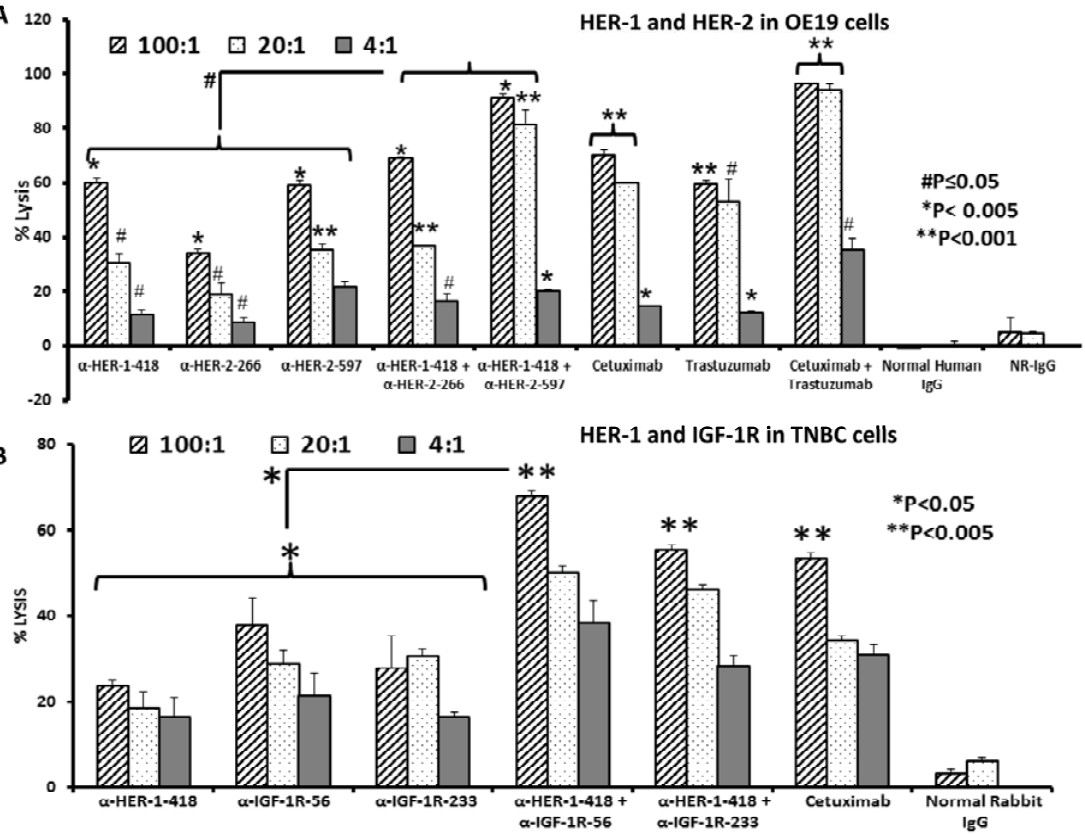
Figure 2. Co-targeting HER-2 and HER-1 or IGF-1R and HER-1 causes greater induction of ADCC in EC and TNBC. OE19 or MDA-MB-231 cells were used as target cells and were seeded and incubated in the presence of human PBMCs at different effector: Target cell ratios (100:1, 20:1, 4:1). Cells were then treated for one hour with peptide vaccine antibodies prior to cell lysis. The aCella-tox kit (Cell Technology, Inc.; Fremont, CA, USA) was used to measure the relative amount of ADCC; cell lysis was measured according to the manufacturer’s instructions. Results represent an average of two different experiments performed in triplicate and display the % lysis of treatment groups when compared to 100% target cell lysis. Normal human and rabbit IgG (Pierce, Rockford, IL, USA) were used as a negative control; cetuximab and trastuzumab were positive controls . In EC cells, at a 100:1 ratio ( A ), single treatment with the anti-HER-2 and anti-HER-1 peptide vaccine antibodies showed significant induction of ADCC (* p < 0.005), but combination treatment using the anti-HER-1-418 and anti-HER-2-597 or anti-HER-1-418 and anti-HER-2-266 peptide vaccine antibodies caused greater induction of ADCC (# p < 0.05) than single treatment alone. In TNBC cells, at a ratio of 100:1 ( B ), anti-HER-1-418, anti-IGF-1R-56, and anti-IGF-1R-233 peptide vaccine antibodies induced significant levels of ADCC as compared to negative control (* p < 0.05). The combination of anti-HER-1-418 and anti-IGF-1R-56 induced significantly higher levels of ADCC compared to single treatment alone (* p <